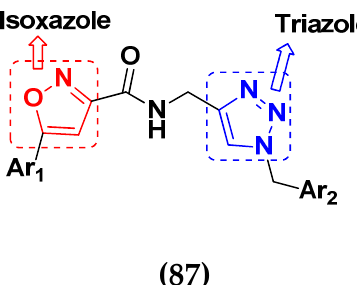
Figure 84. Structure of triazole-isoxazole derivatives ( 87 ).